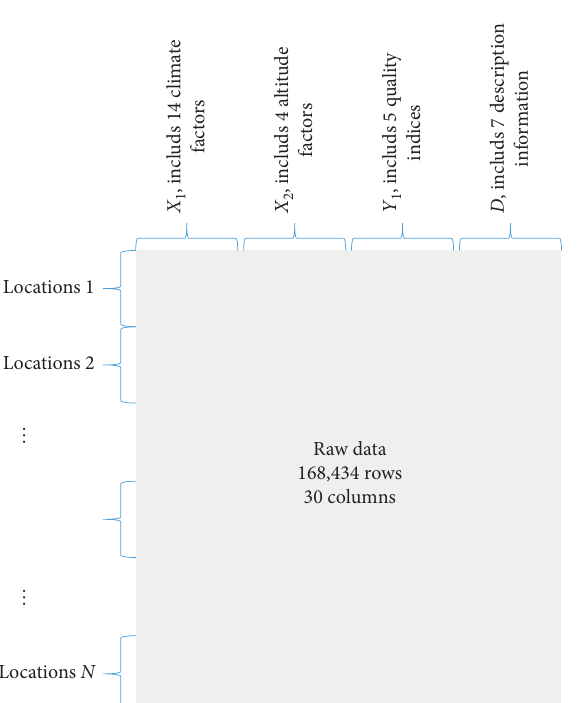
Figure 3: The structure of original data applied as an example to introduce the strategy of the PCA/MCEA